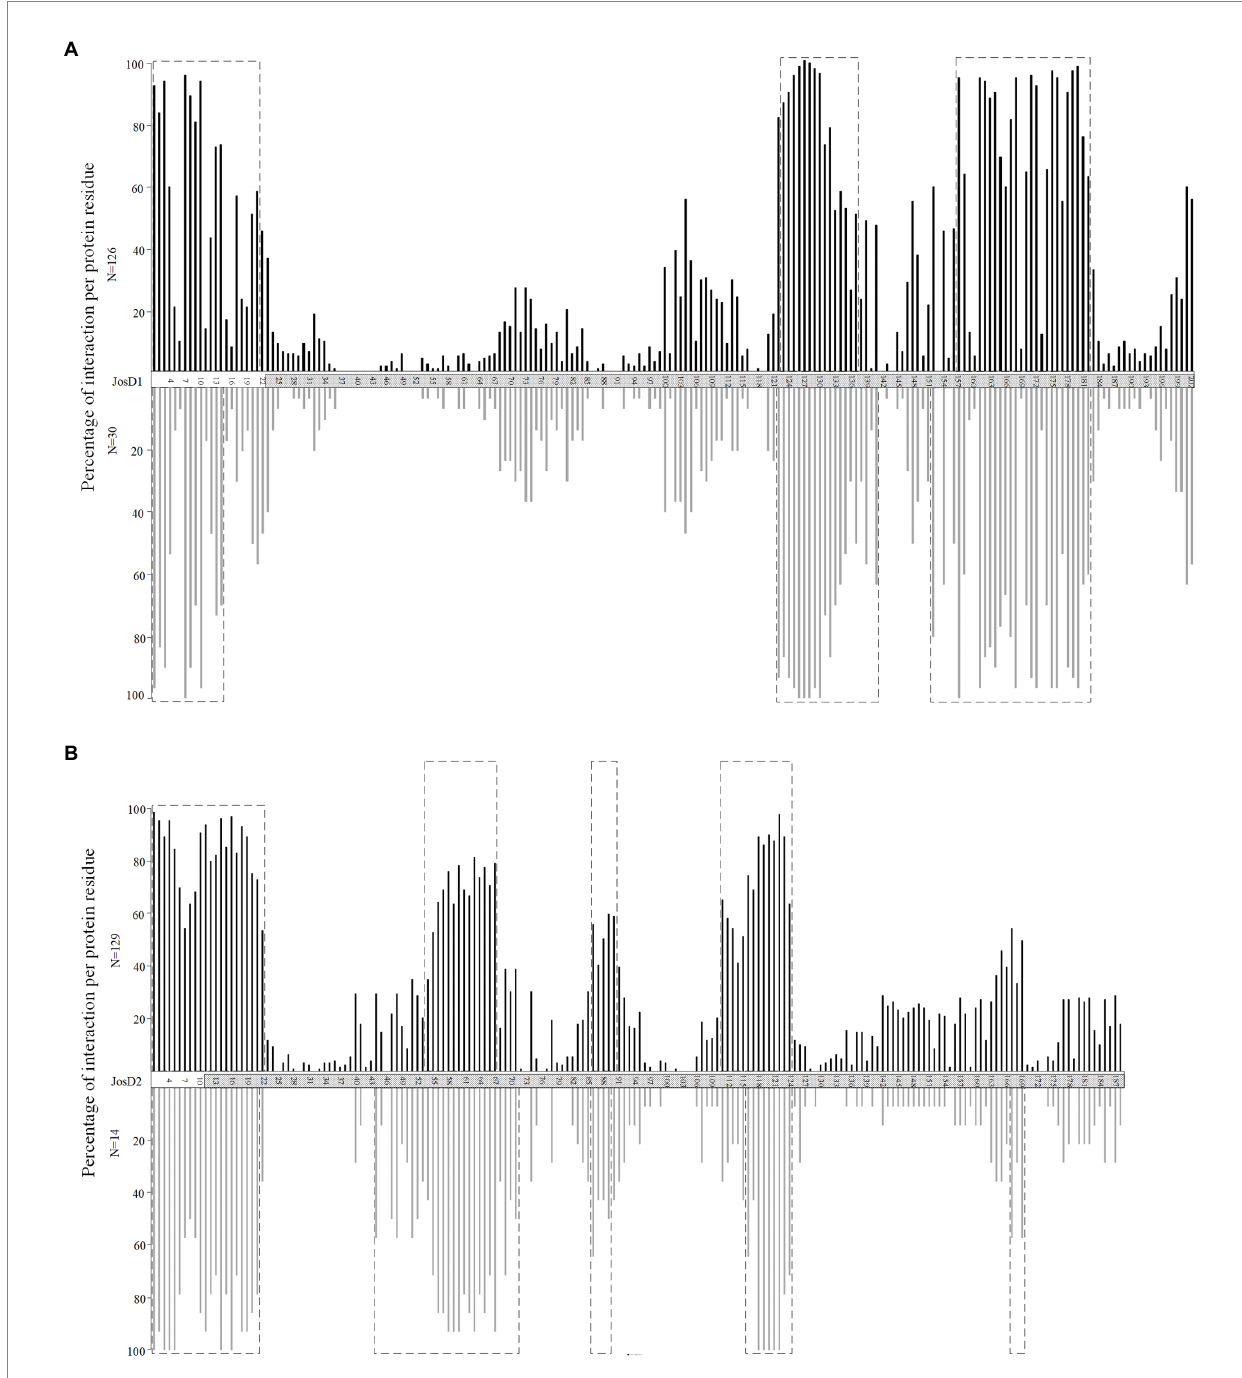
FIGURE 4 Percentage of interaction per protein residue at the JOS1 (A) and JOS2 (B) for predicted interactors (those of the ataxin-3; upper panel, in black) and those that are described as the JOS1 and JOS2 interactors (lower panel, in gray), respectively. The interactors in common were excluded from this analysis. Dotted boxes represent regions of interaction where more than 50 percent of the proteins show interaction with JosD1 and JosD2, respectively. The Josephin domain (JD) is assigned as a dotted